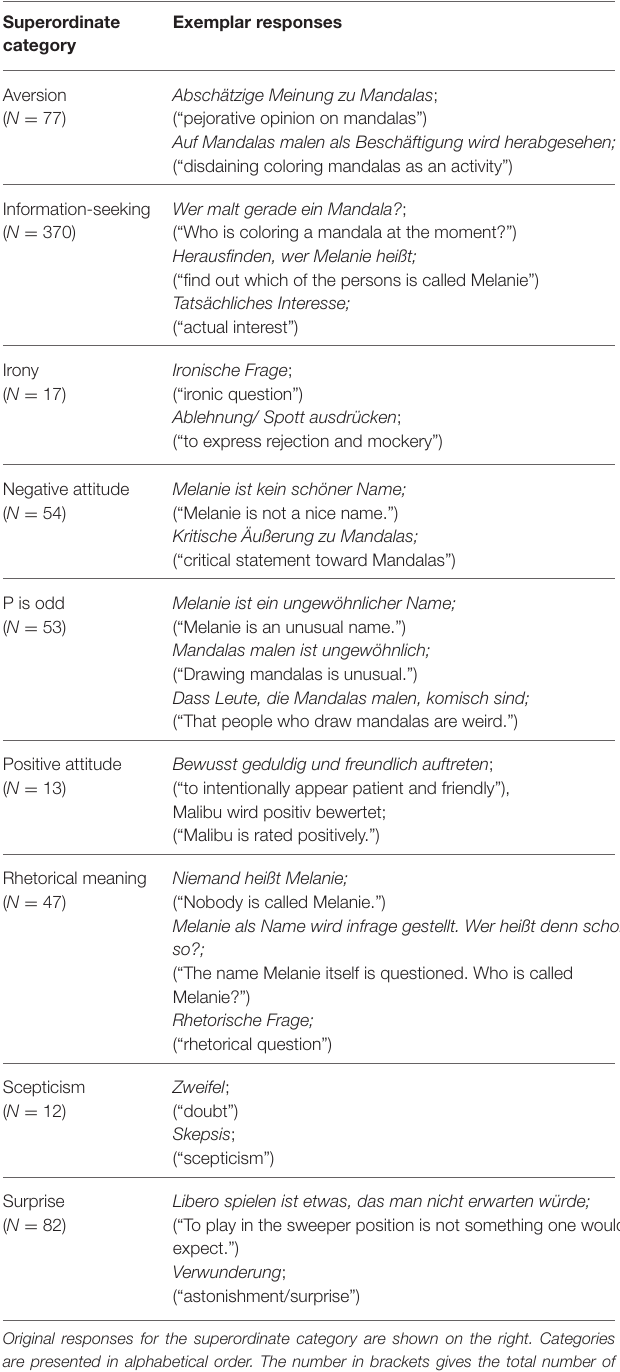
TABLE 4 | Nine most frequent superordinate categories inferred from participants’